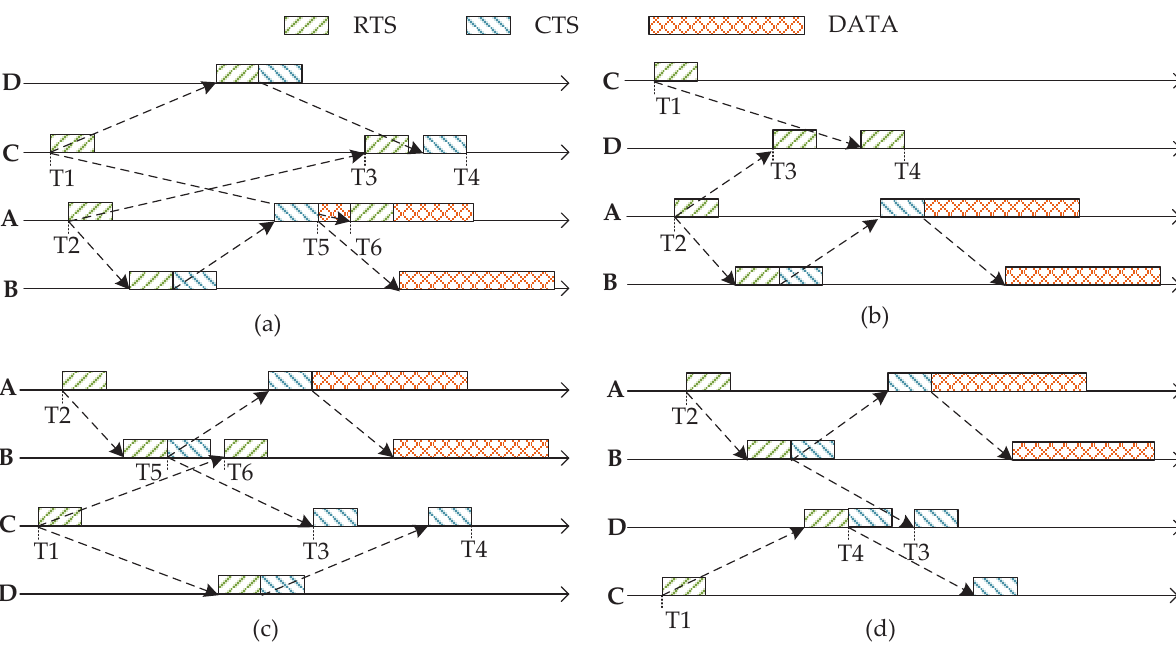
Figure 2. Timing Diagram of spatial unfairness scenarios. ( a ) The exposed transmit terminal. ( b ) The exposed receive terminal. ( c ) The hidden transmit terminal. ( d ) The hidden receive